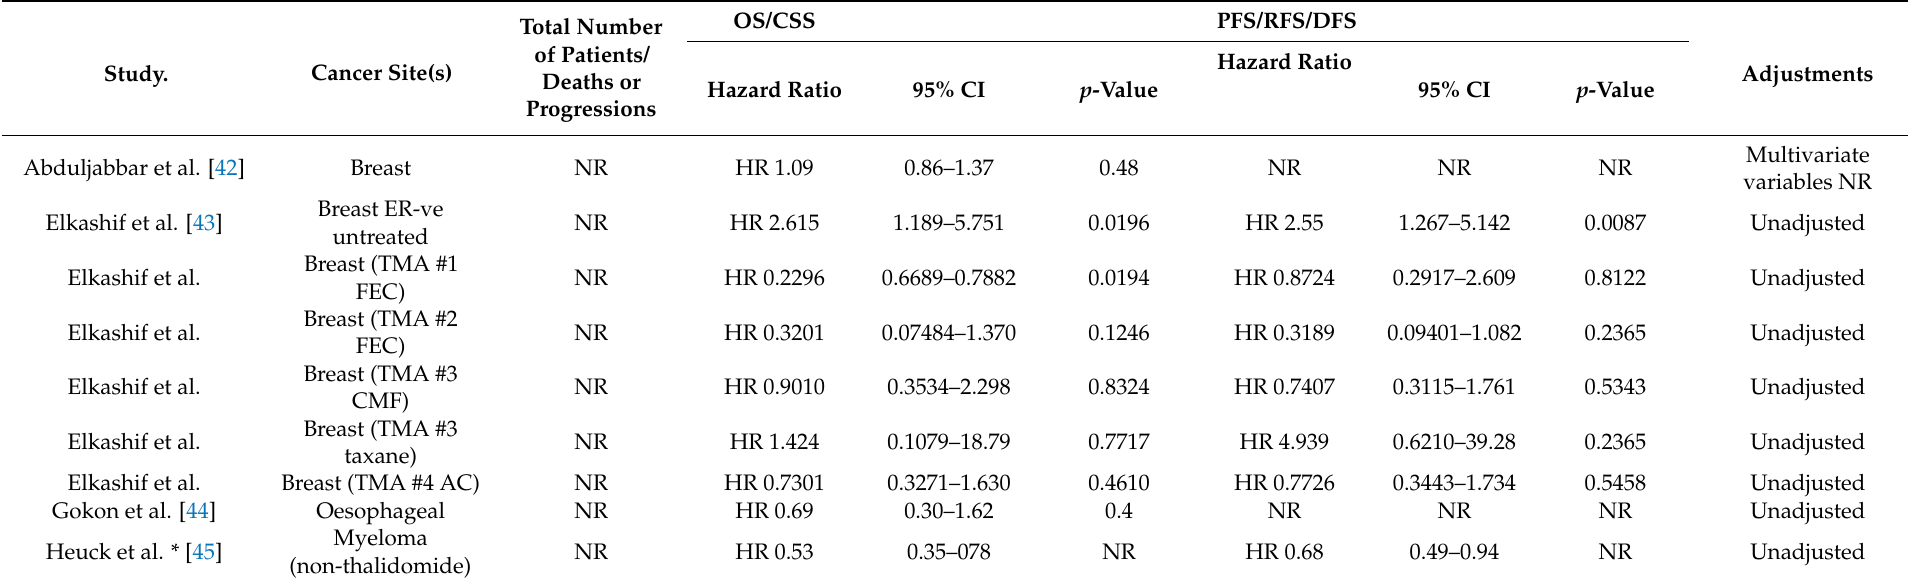
Table 2. Survival data of articles included in